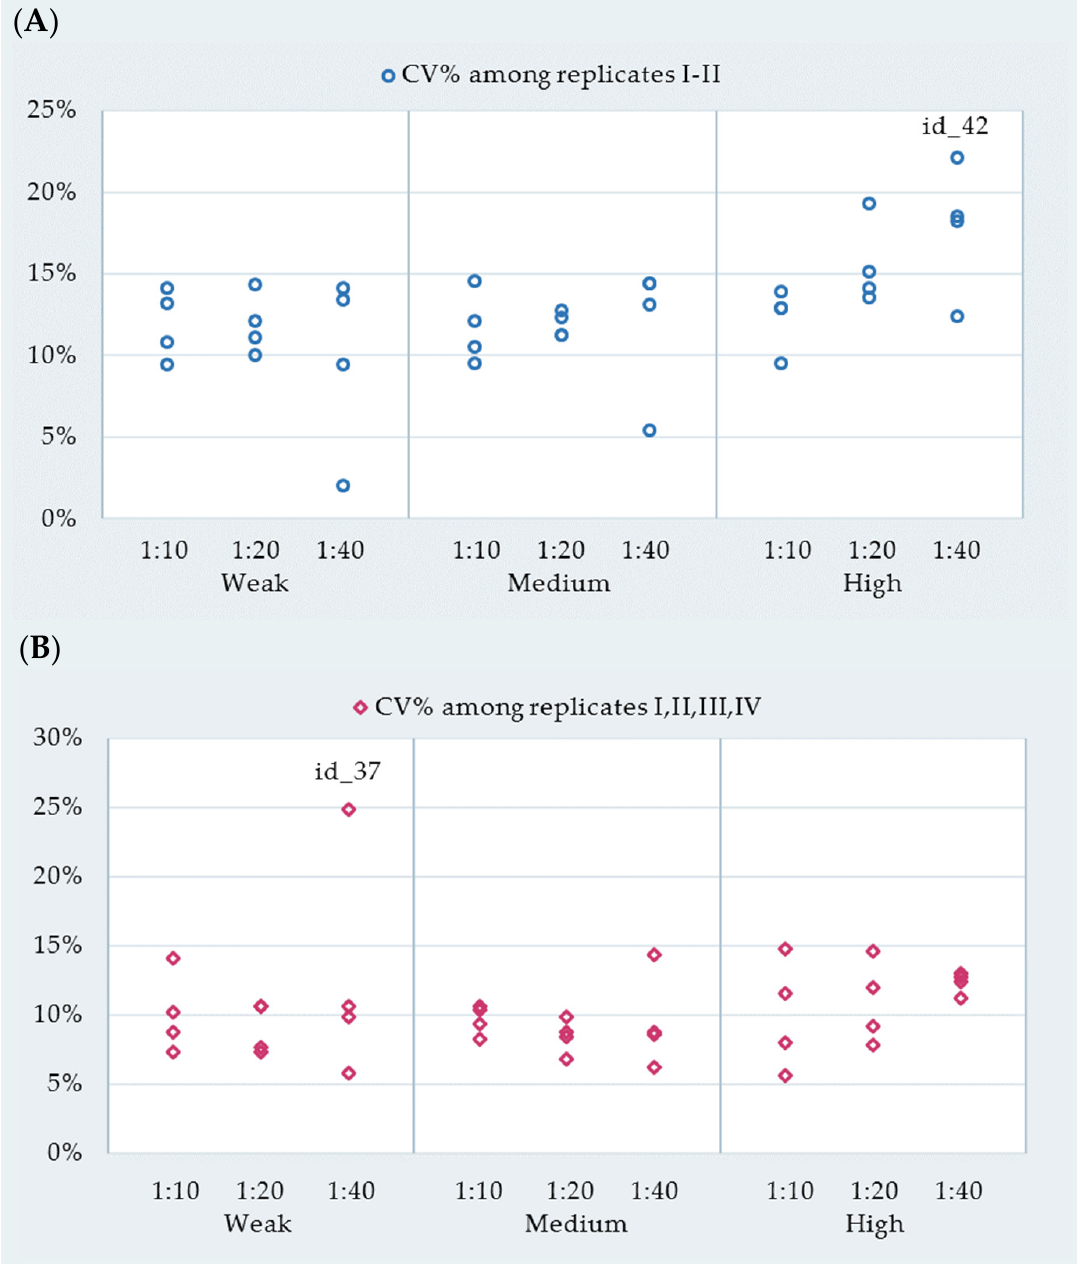
Figure 2. ( A ) Within-run coefficient of variability (CV%) among replicates I–II performed on each positive reference sample per reactivity level and dilution ratio. ( B ) Between-run coefficient of variability (CV%) among replicates I–IV performed on each positive reference sample per reactivity level and dilution ratio. For each reactivity group and dilution, there are four dots. Each dot represents the CV% among the replicates, performed on a single positive reference sample belonging to that reactivity level and originating from that dilution. The highest values of CV% were labelled as follows to aid communication: the CV% of a 1:40 diluted id-42 individual milk and the CV% of a 1:40 diluted id-37 individual milk.